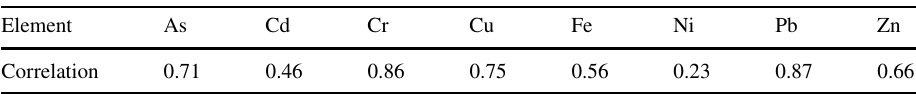
Table 6 Correlation of metals between wet and dry seasons